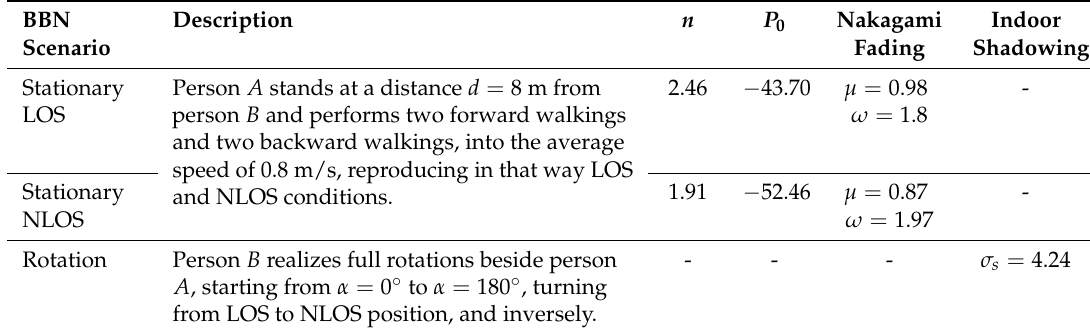
Table 5. BBN scenarios in indoor